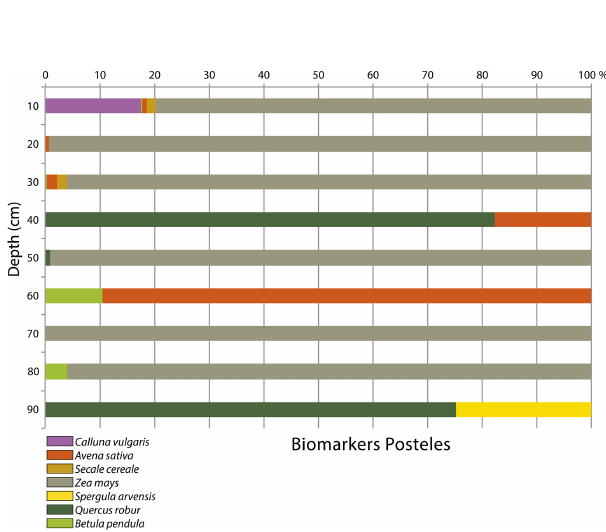
Figure 12. Pollen diagram Posteles; pollen density in kgrainmL − 1 .